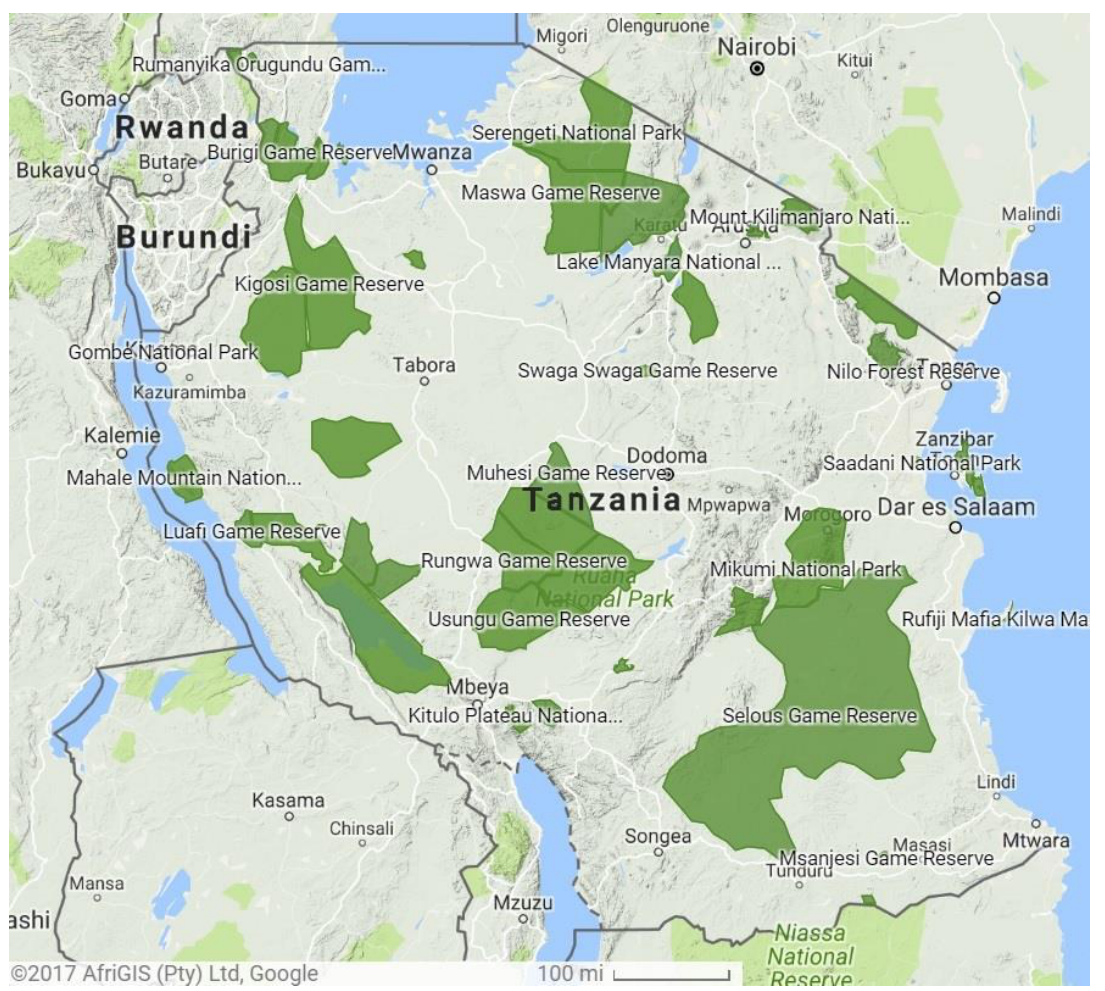
Figure 1. Map of Tanzania’s protected areas.